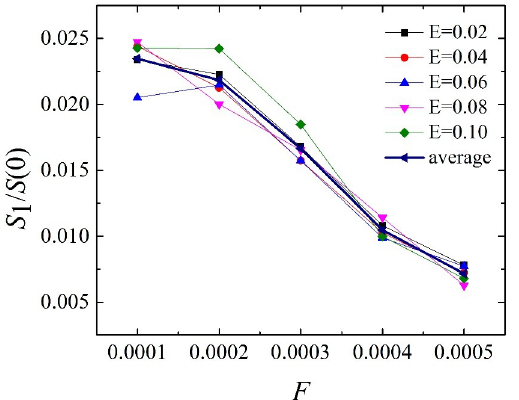
Fig 6. For the specified electric field strength, under different driving forces, the normalised main peak of the static structure in the plane, S (G1)/ S (0).